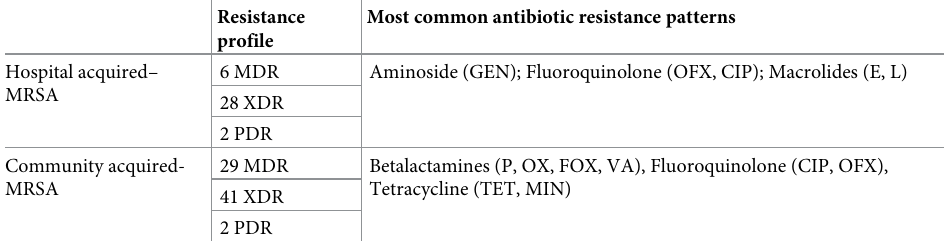
Table 6. Antimicrobial susceptibility profile of S . aureus .